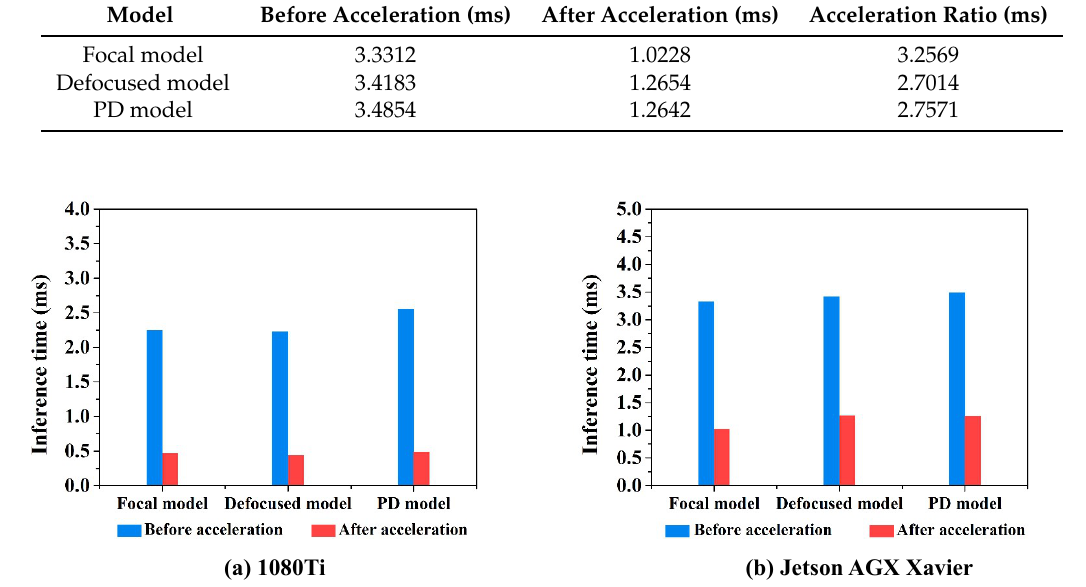
Figure 13. ( a ) The average inference time of PD-CNN models for 3000 samples on 1080Ti. ( b ) The average inference time of PD-CNN models for 3000 samples on Jetson AGX